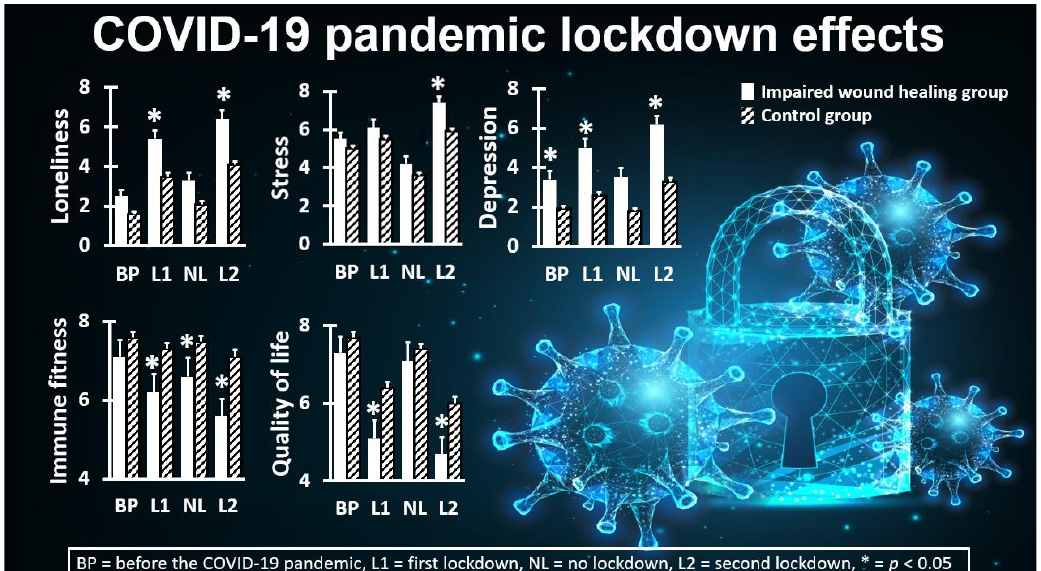
Figure 4. Examples of COVID-19 lockdown effects among individuals with and without self-reported impaired wound healing. Loneliness, stress, and depression were assessed on a scale ranging from 0 (absent) to 10 (extreme) [12]. Sleep quality and quality of life were assessed on a scale ranging from 0 (very poor) to 10 (excellent) [12]. For each time period, significant ( p < 0.0167) differences between individuals with impaired wound healing (striped bars) and individuals without impaired wound healing (white bars) are indicated with *. Data from references [10,32]. Permission to use the background image was obtained from